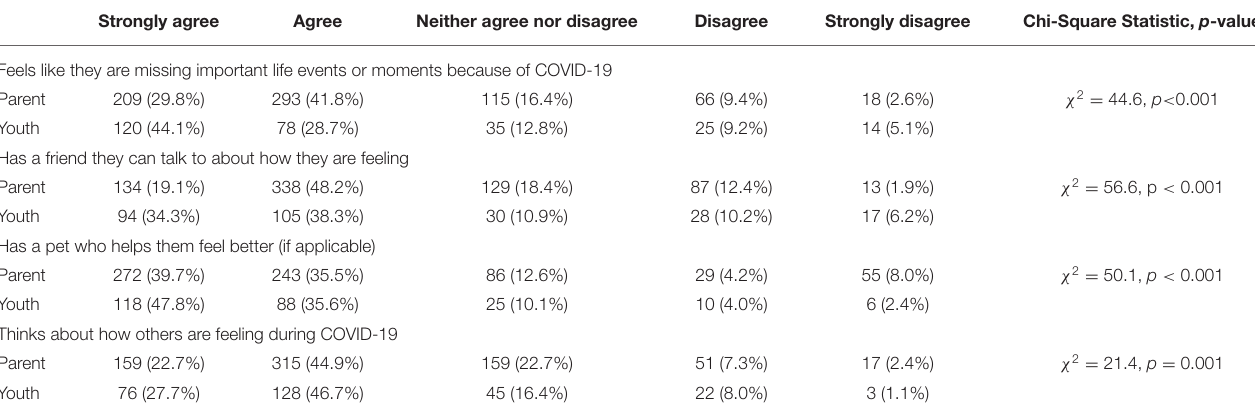
TABLE 2 | Thoughts and feelings about COVID-19 reported by parents and youth. Strongly agree Agree Neither agree nor disagree Disagree Strongly disagree Chi-Square Statistic, p